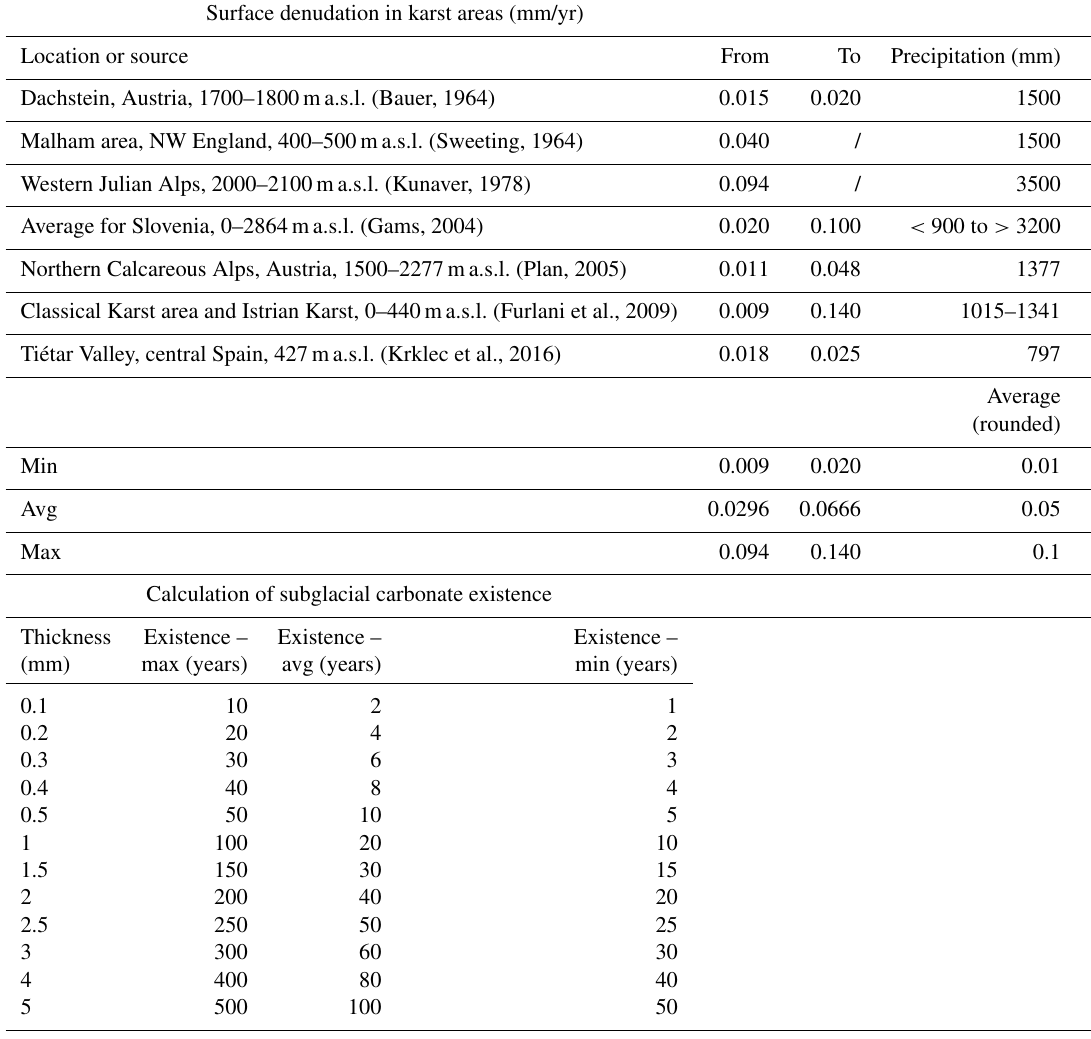
Table 1. Calculation of subglacial carbonate existence under a meteoric environment based on the carbonate’s thickness, years of exposure and denudation